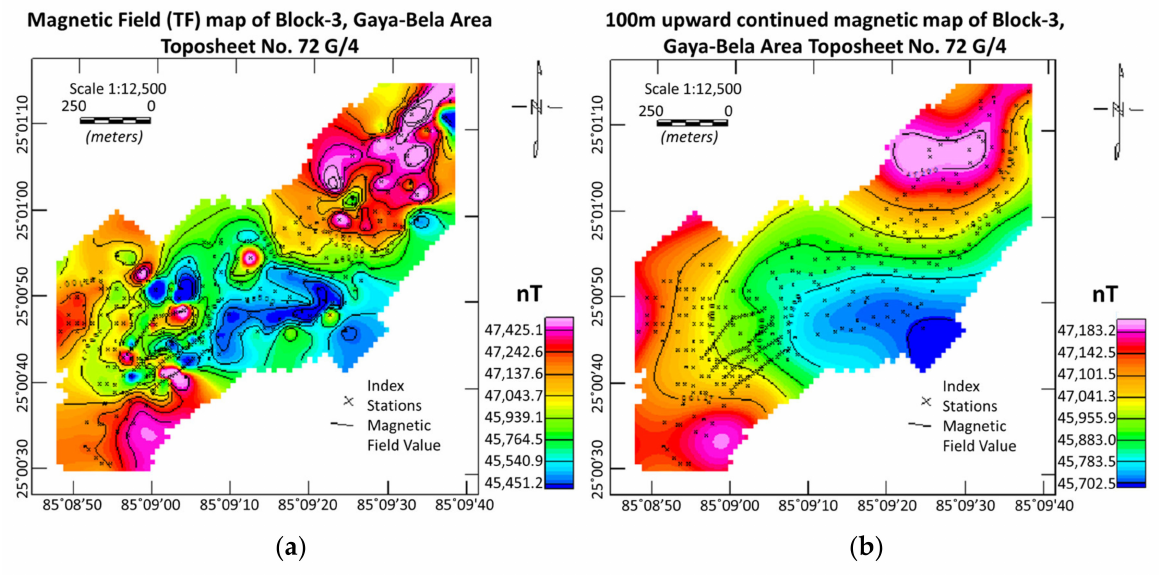
Figure 18. ( a ) Magnetic map (TF) of Block-3, and ( b ) Upward continued magnetic map of Block-3